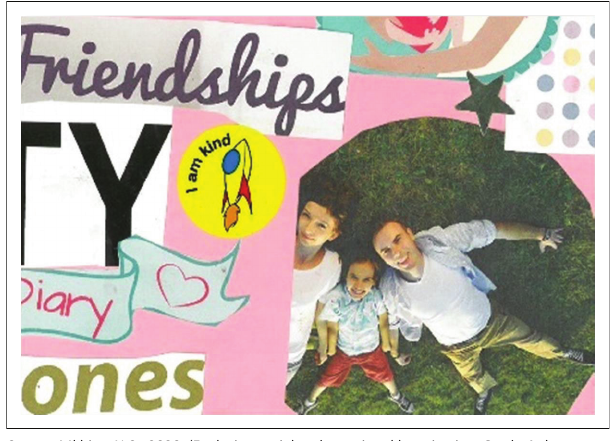
FIGURE 3: Cultivating social and emotional